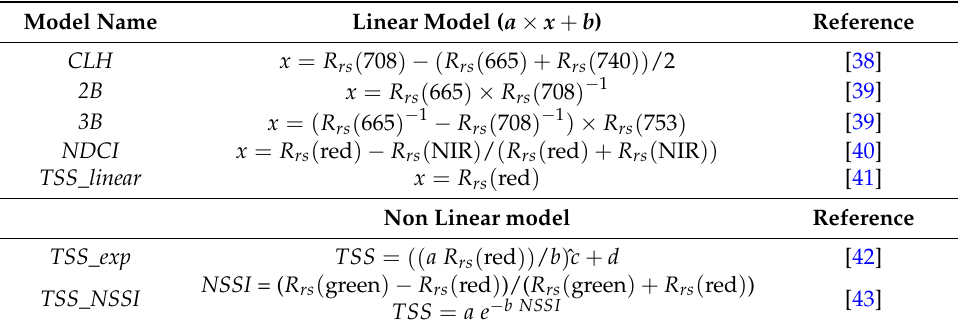
Table 7. Chl-a and TSS algorithms. The exact wavelength used changed for each sensor. CLH is a chlorophyll line height model, 2B is a red/NIR band ratio model, 3B is a red/NIR 3 band model, NDCI is a red NIR 2 band model, TSS_linear is a linear red band model, TSS_exp is an exponential red band model, and TSS_NSSI is a red/green exponential band ratio